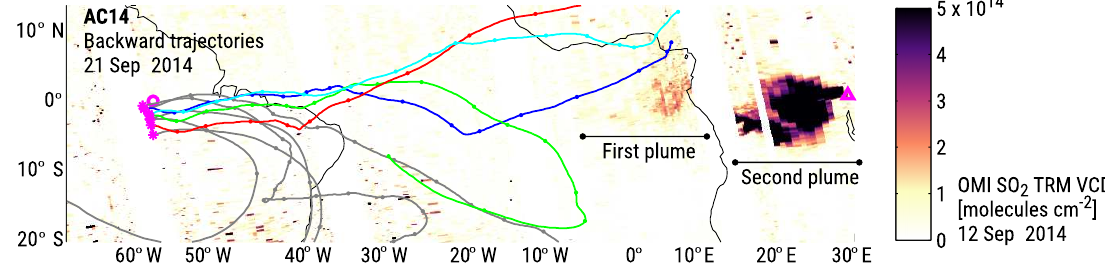
Figure 7. Map of gridded OMI SO 2 VCD observed on 12 September 2014. Two plumes are shown on the map; the first one emitted on 7 September 2014 and the second one emitted on 12 September 2014. The 15-day backward trajectories initialized at several points along the track of flight AC14 (21 September 2014) at flight altitude are shown as continuous lines with dots. Trajectories starting at points where sulfate-to-OA ratios >1 are shown in color (see Table 1 for details), and all other trajectories are shown in gray; dots are placed at 24h intervals. The path of flight AC14 is marked in pink, with stars denoting the starting points of the backward trajectories. The locations of the ATTO site and Nyamuragira are marked with a pink circle and a triangle, respectively. Table 1. Measurements at points along the track of flight AC14 (21 September 2014) selected as starting points for backward trajectories presented in Fig. 7. Data points with a sulfate-to-OA ratio >1 are emphasized by bold font.